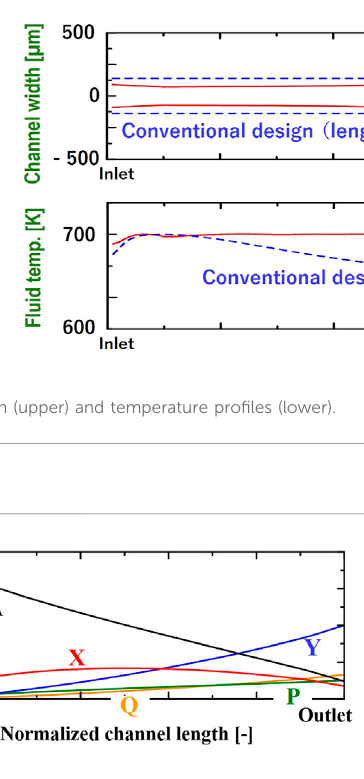
FIGURE 7 Composition pro fi les in the optimally designed channel.